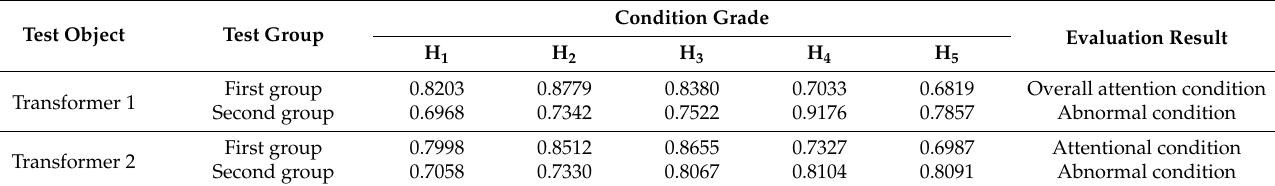
Table A1. Case 1 (Transformer 1) and Case 2 (Transformer 2) in